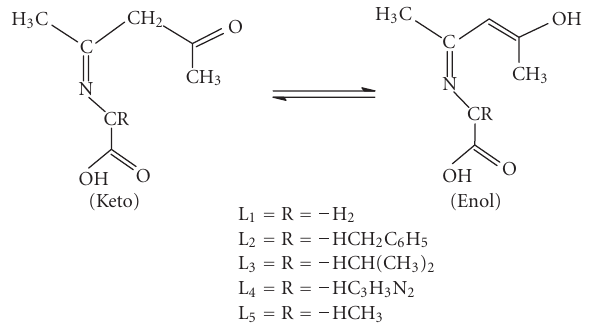
Figure 1: Proposed structure of the ligands (L 1 )–(L 5